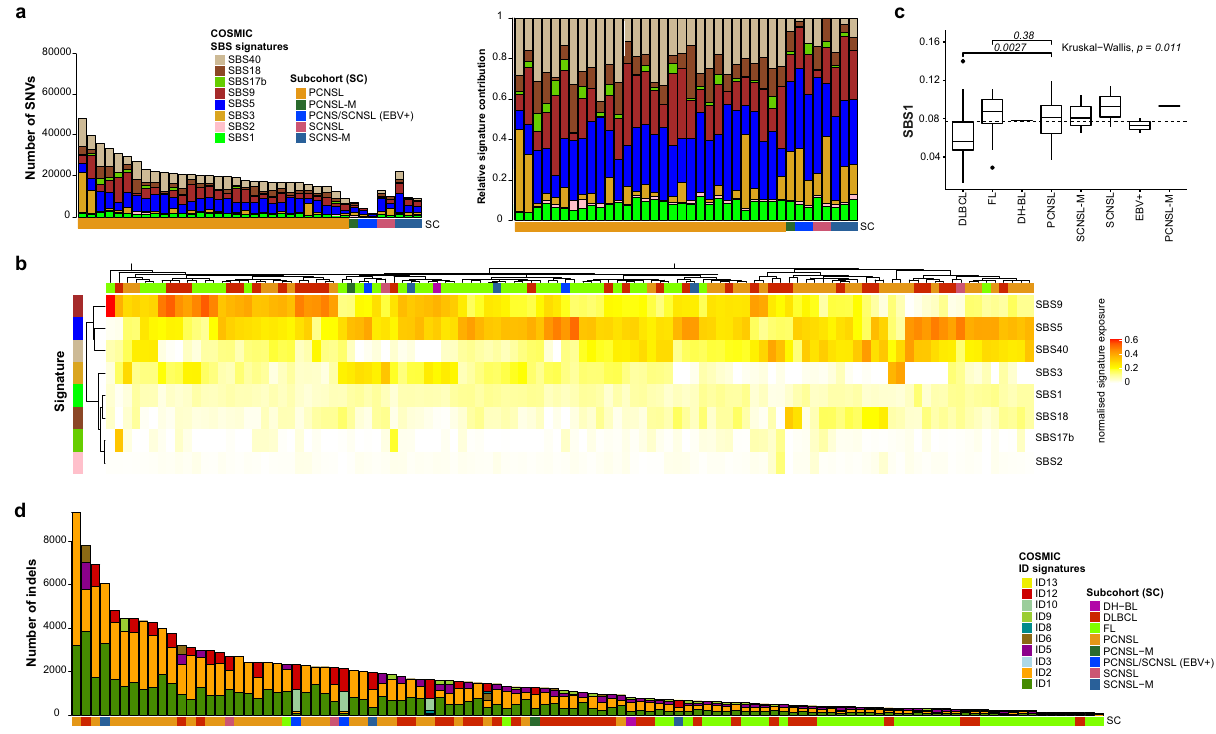
Fig. 6 Mutational signatures in PCNSL. Single base substitution (SBS) signature contribution in PCNSL and SCNSL. Stacked bar plots are ordered by subgroup and then decreasing mutations load ( a ). The left bar plot shows the number of SNVs and the right shows the normalized signature exposures. Each color corresponds to a mutations signature and the proportion of the color re fl ects the number or proportion of SNVs explained by a certain mutational signature. The heatmap shows the clustering pattern of the SBS mutational signatures in all CNSL and peripheral lymphomas ( b ), which revealed groupings mutational signatures SBS5, SBS9, and SBS40. Pairwise comparison of PCNSL with DLBCL or FL (Mann – Whitney U test) revealed that signature SBS1 was signi fi cantly enriched in PCNSL compared to DLBCL ( p = 0.027; c ). Box and whisker plots show median (center line), the upper and lower quartiles (the box), and the range of the data (the whiskers), excluding outliers. Small insertion and deletion (ID) signatures in CNSL and peripheral lymphoma ( d ) demonstrate elevated numbers of indels and mutational patterns associated with slippage during DNA replication of the replicated DNA strand (ID1) and template DNA strand (ID2) in